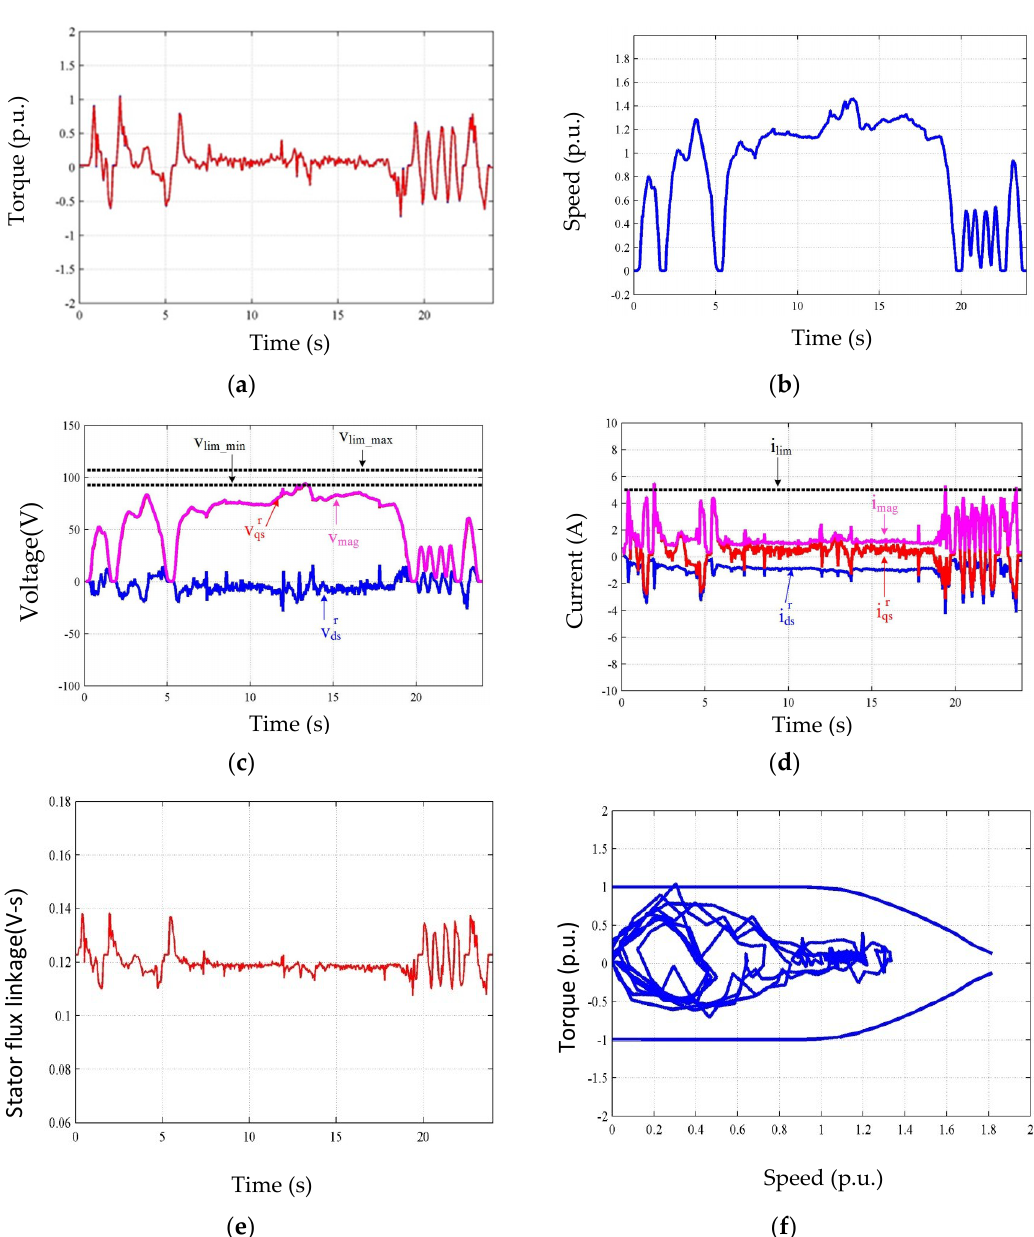
Figure 8. Simulation results of motor dynamics along the US06 SFTP (supplemental federal test procedure) driving cycle. ( a ) Torque; ( b ) Speed; ( c ) Voltage; ( d ) Current; ( e ) Stator flux linkage; ( f ) Torque-speed .